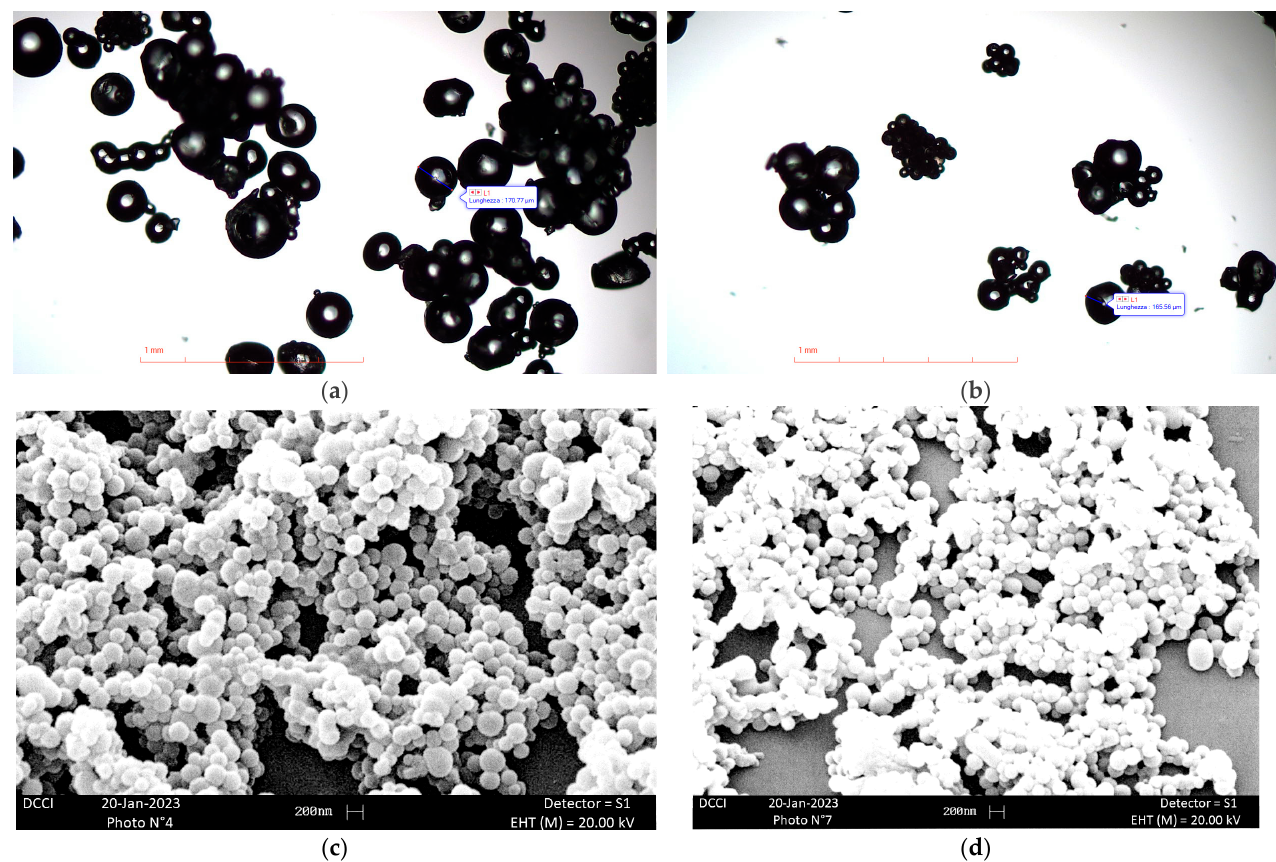
Figure 2. Optic images (using a 4× objective) of R2 showing micro-dimensioned particles of 171 µm ( a ) and 166 µm ( b ); SEM images of R2 ( c , d ).